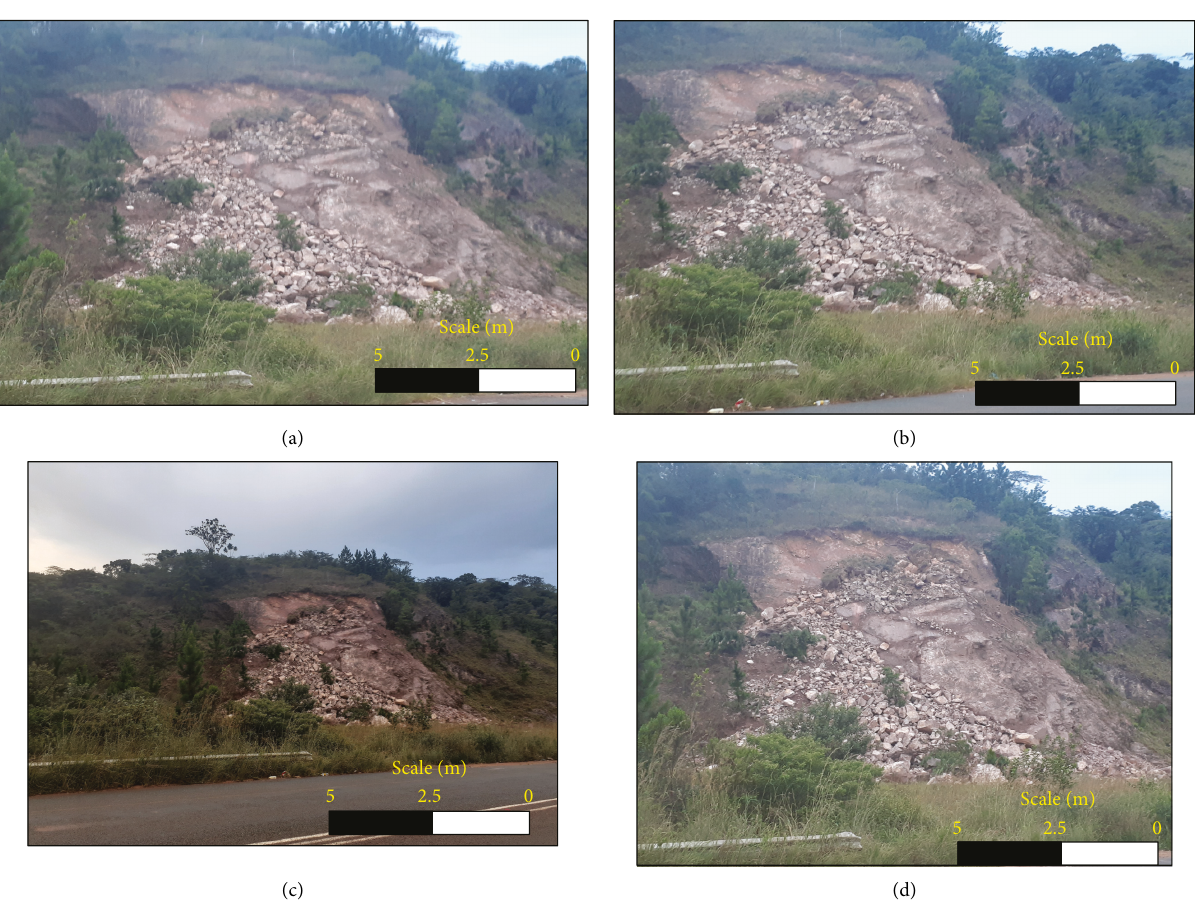
Figure 5: (a) Slope instability took place in the study area, with broken rock deposited at the bottom of the slope. (b) and (d) Some of the bedding planes along with the slope. (c) 3D of the affected slope with the surrounding unaffected